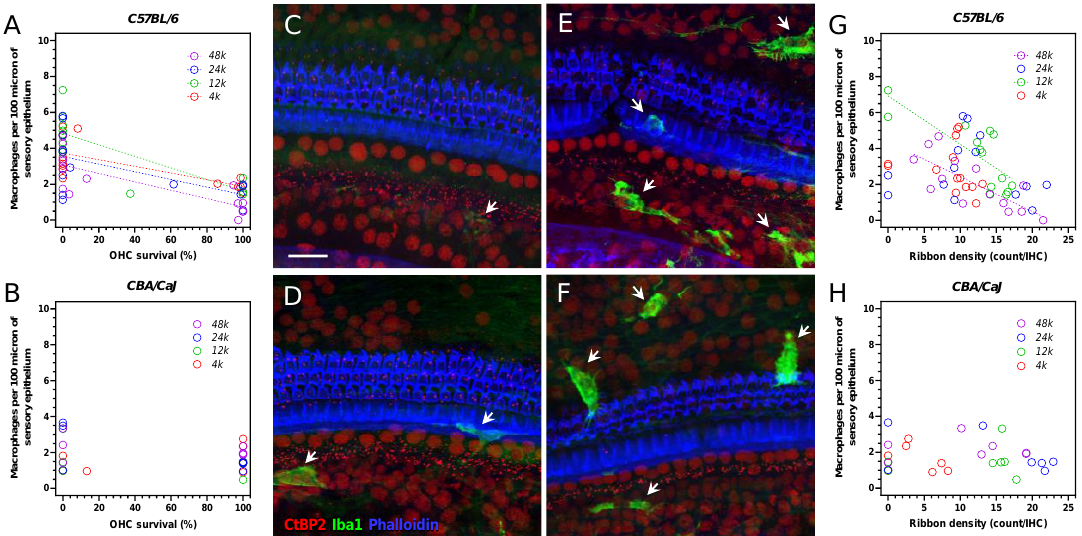
Figure 6. Macrophage density correlated to OHC survival and synaptic ribbon density in B6 mice but not in CBA mice 15 days after G/F treatment. ( A ): Macrophage density and OHC survival were correlated at all examined cochlear locations 15-day posttreatment in B6 mice, by Pearson’s r test. Such correlation was not observed in CBA mice ( B ). Confocal images demonstrate intact cochlear morphology of the sensory epithelium with moderated macrophage activities (while arrows) at the 24-kHz location 15 days after G/F treatment from a B6 ( C ) and a CBA ( D ) mouse. Scale bar = 20 µm. When G/F-induced ototoxicity was evident, reflected by a partial or complete OHC loss, elevated macrophage activity could be seen from many individual samples at the 24-kHz location, e.g., from a B6 ( E ) and a CBA ( F ) mouse. ( G ): Macrophage density and ribbon density were correlated at 12-kHz and 48-kHz frequency locations in B6 mice. Such correlation was not observed in CBA mice ( H ).